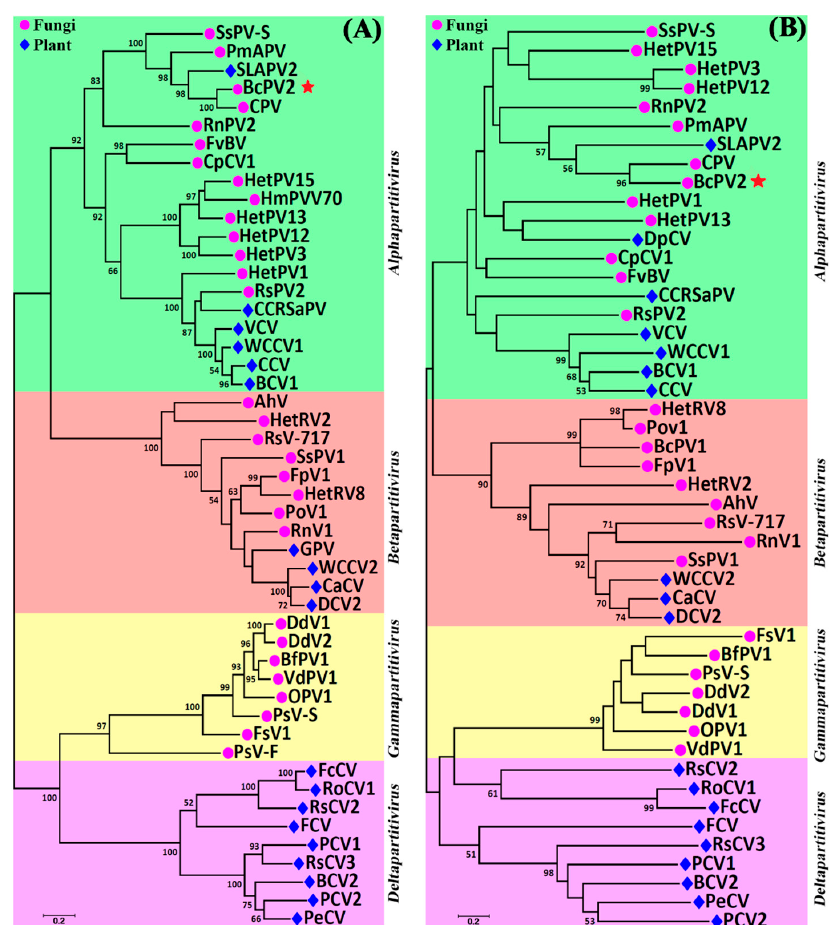
Figure 7. Two phylogenetic trees showing the relationship of BcPV2 with other partitiviruses. The trees were inferred based on amino acid sequences of RdRp ( A ) and CP ( B ) using the Maximum-Likelihood method with bootstrap values determined by 1000 replicates. Bootstrap values higher than 50% are shown in the graphs. The scale bars represent substitutions per nucleotide position. Abbreviations: AhV, Atkinsonella hypoxylon partitivirus; BcPV1, Botrytis cinerea Partitivirus 1; BcPV2, Botrytis cinerea Partitivirus 2; BCV1, Beet cryptic virus 1; BCV2, Beet cryptic virus 2; BfPV1, Botryotinia fuckeliana